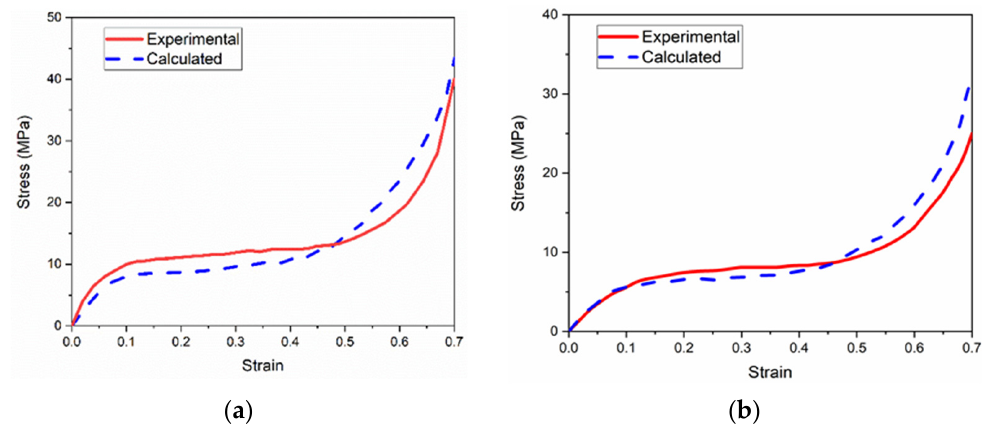
Figure 13. Comparison of experimental and calculated curves of the uniform closed-cell copper foams at ( a ) 300 °C and ( b ) 500 °C.